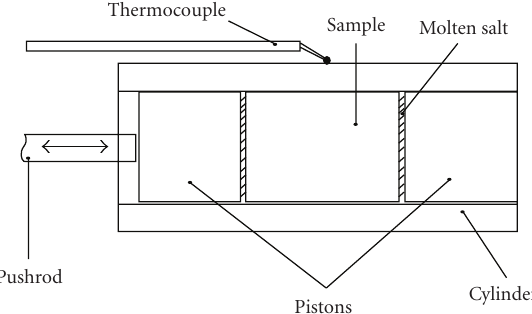
Figure 1: A schematic sketch of the sample supporter in the dilatometer apparatus.